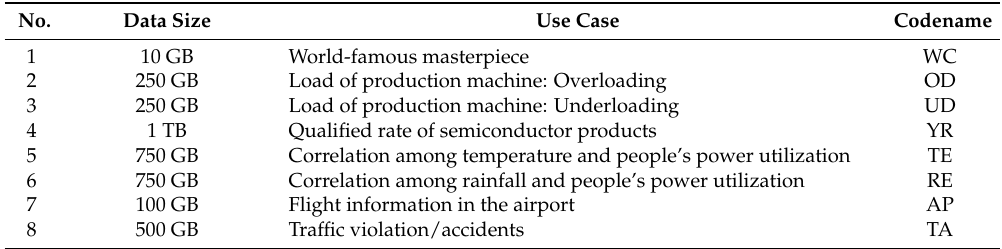
Table 12. Test use